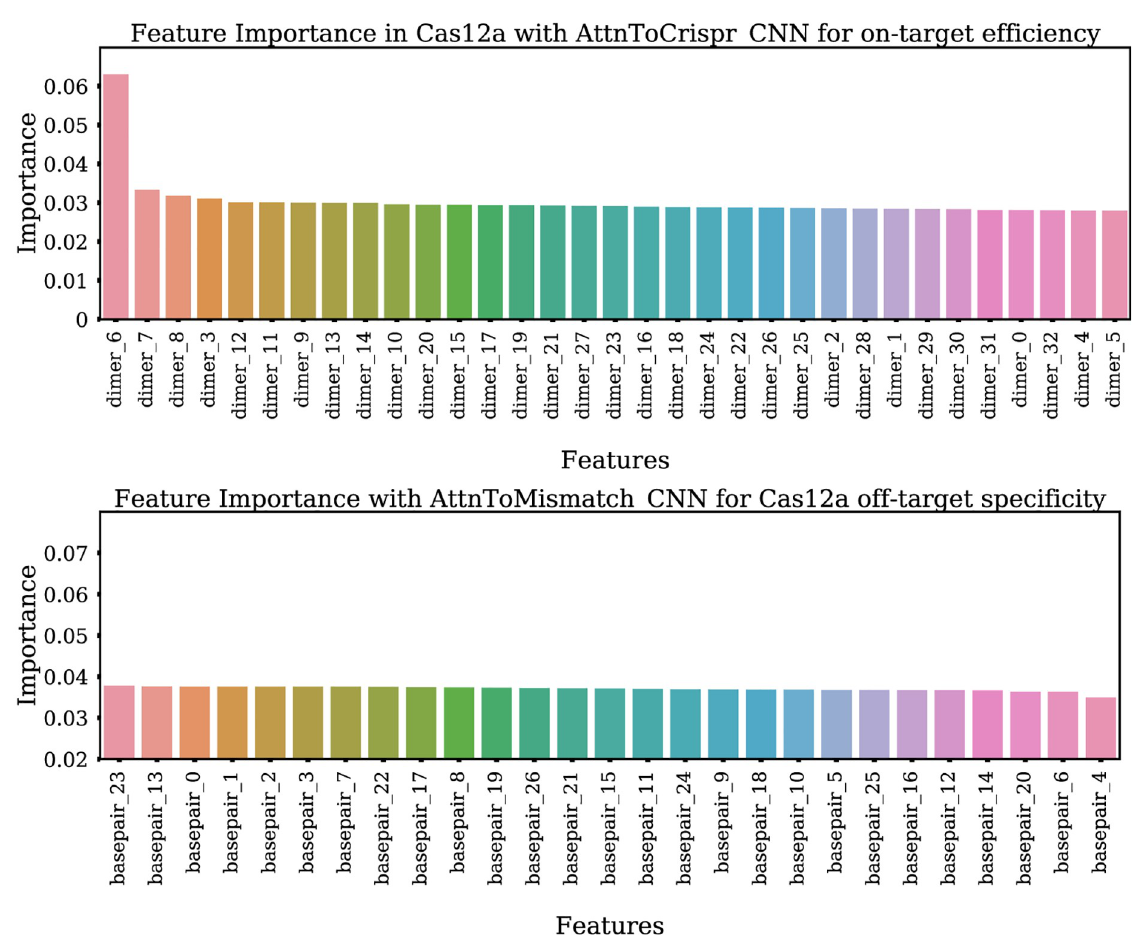
PLOS Computational Biology | https://doi.org/10.1371/journal.pcbi.1007480 October 28,